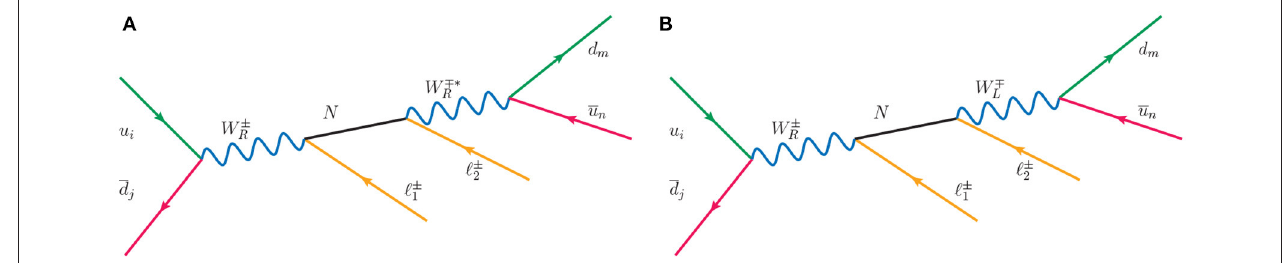
FIGURE 16 | Born-level diagrams depicting resonant W R , N production and decay to same-sign leptons in LRSM via (A) successive right-handed currents and (B) mixed right- and left-handed currents.